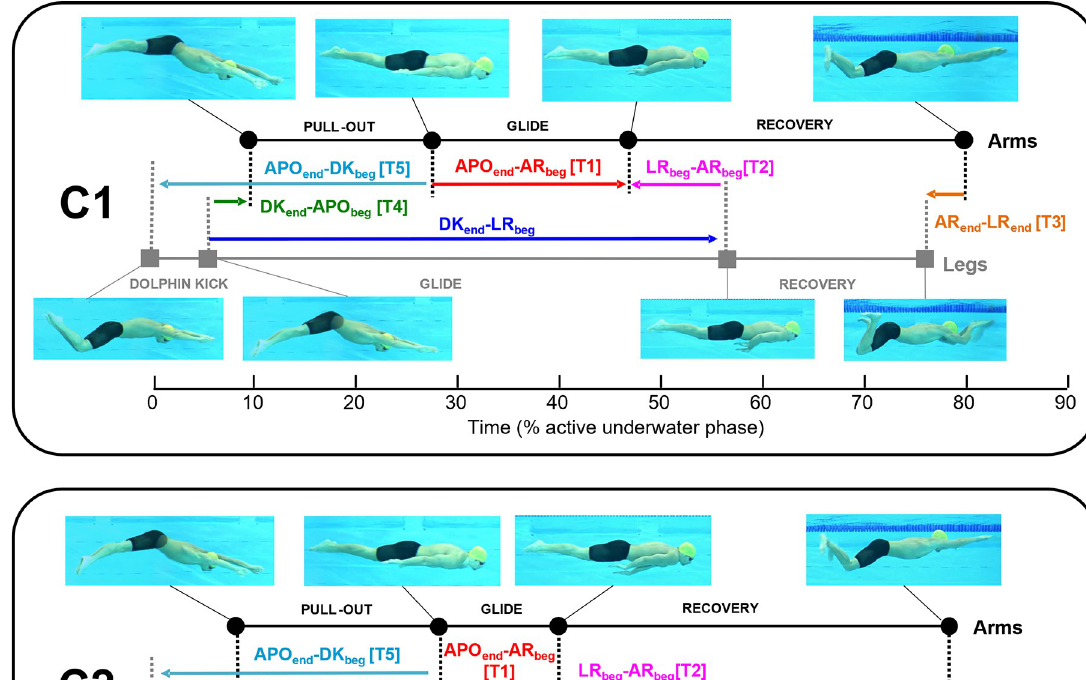
PLOS ONE | https://doi.org/10.1371/journal.pone.0283234 March 21,